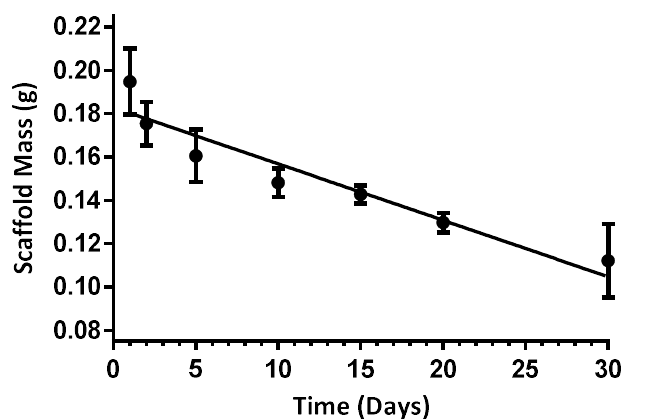
Figure 4. Change in mass of 2% alginate EWA plated with NS-SV-AC over time. Table 0. x + 0.1828. The data is presented as a mean, where the error bars shown represent the SE. n = 3 at each time point.